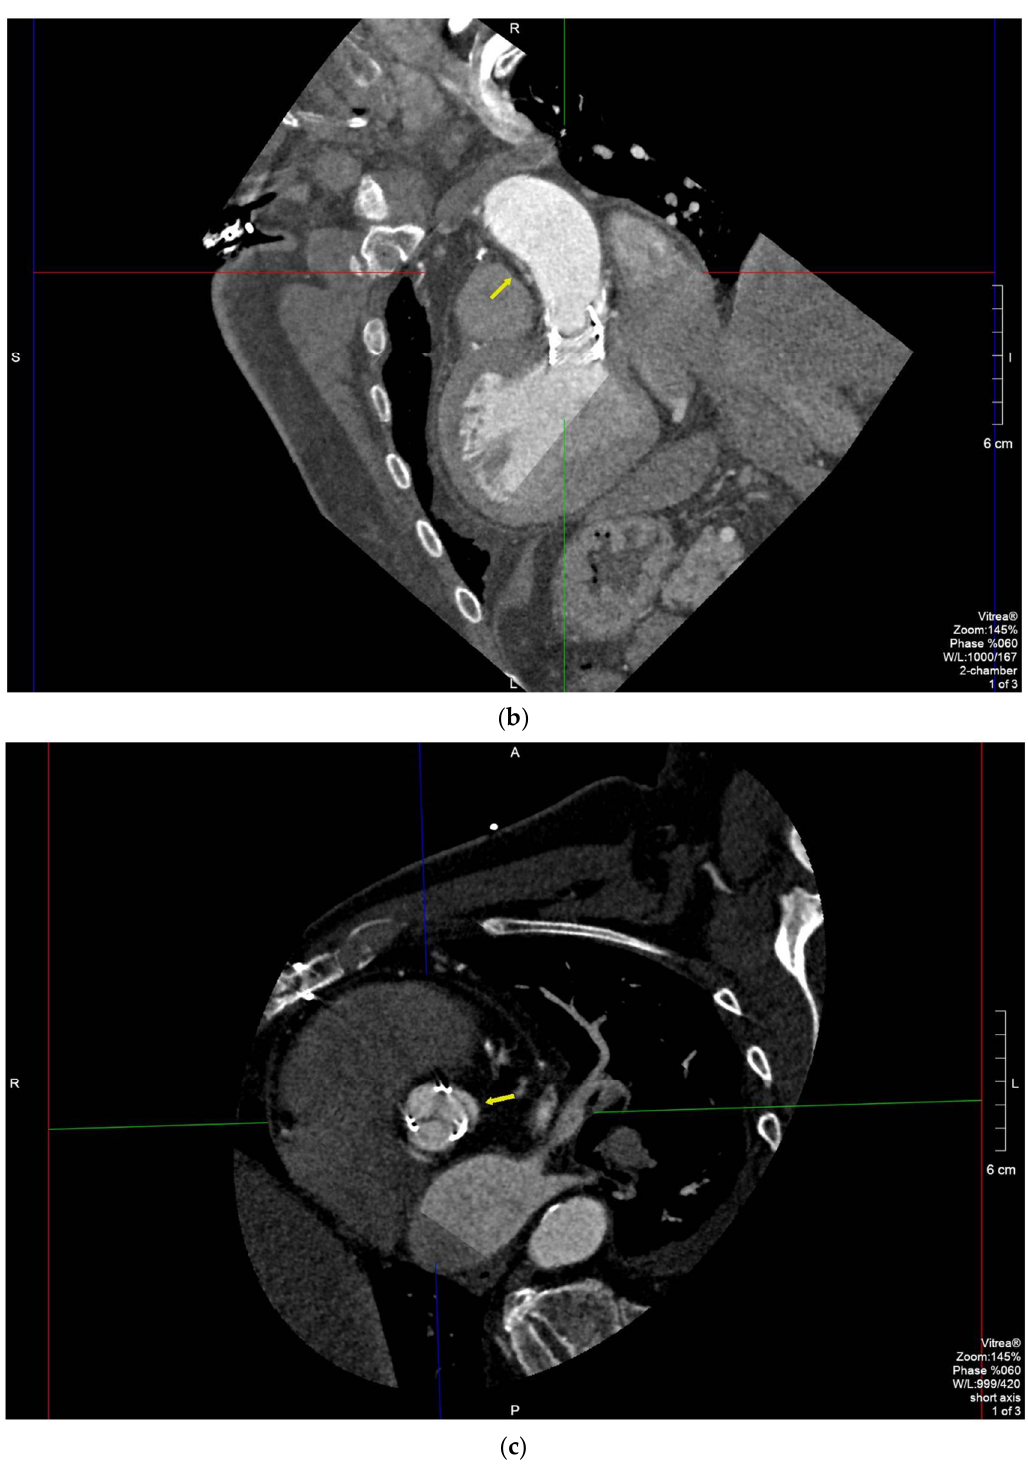
Figure 3. MPR of the aortic annulus to better analyze the pseudoaneurysm (arrows) and its relations with contiguous structures. Long-axis ( a , b ) and short-axis views ( c ) of the peri-prosthesis abscess with discontinuous longitudinal extension for 4 cm communicating with LVOT through a 5 mm window.